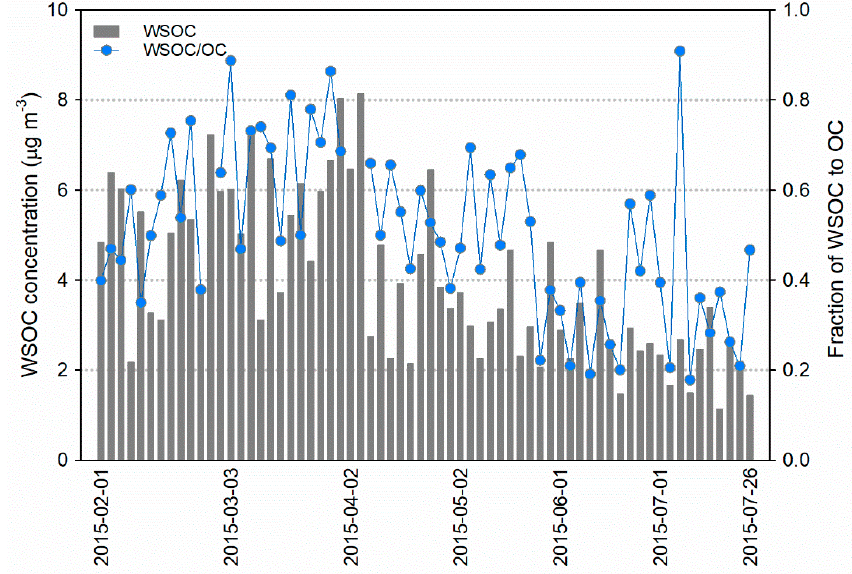
Figure 4. Water soluble organic carbon (WSOC) concentration and WSOC/OC ratios during the whole sampling period.